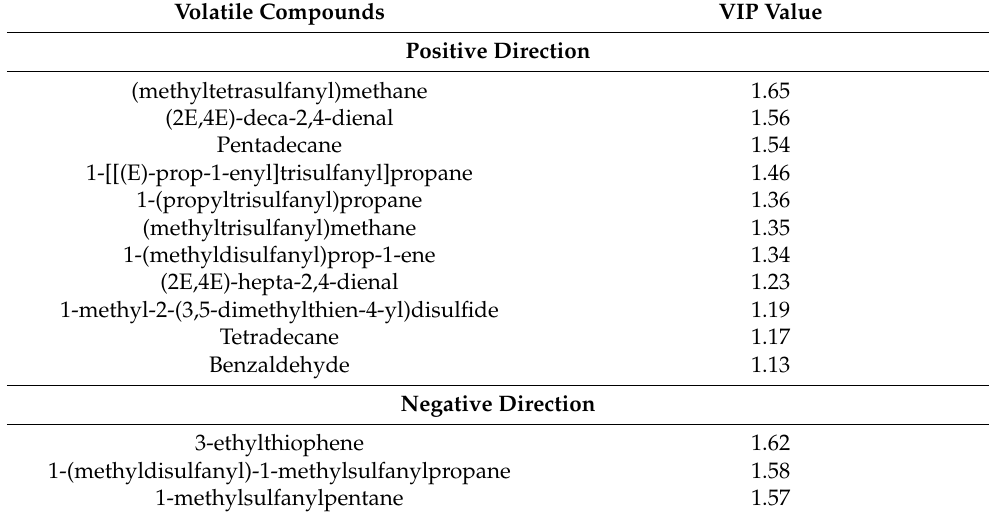
Table 3. The major volatile compounds identified in the heated Welsh onion samples added with different antioxidants, based on the variable importance plot (VIP > 1.0) list for PLS component 1 of PLS-DA.